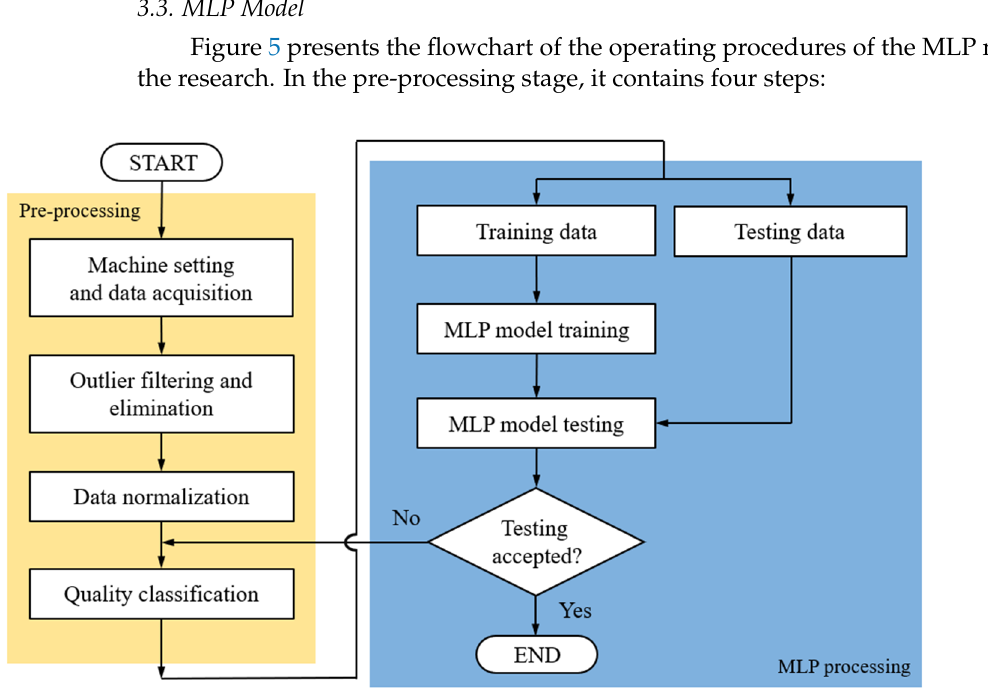
Figure 5. Flowchart of multilayer perceptron (MLP)